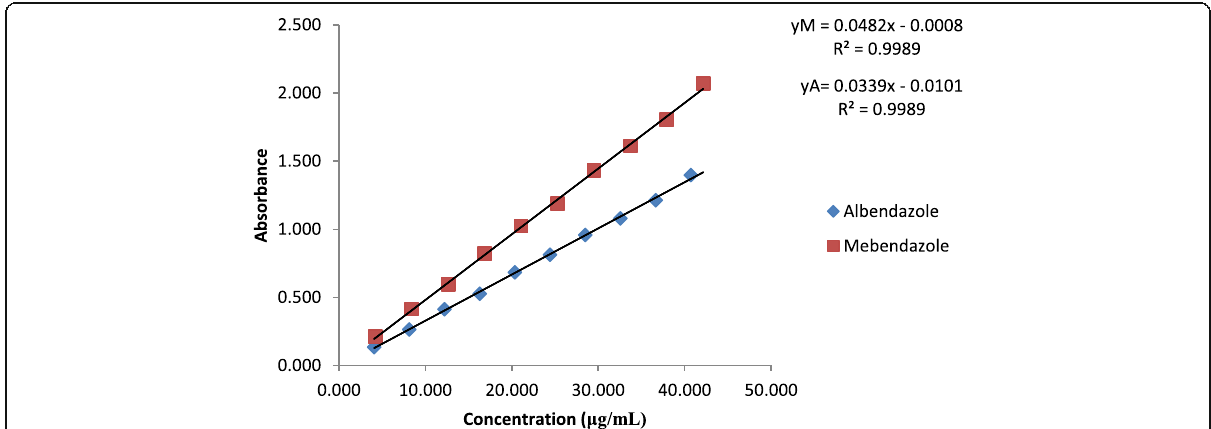
Fig. 3 Linearity plots for albendazole and mebendazole. yA albendazole absorbance, yM mebendazole absorbance, x API concentration